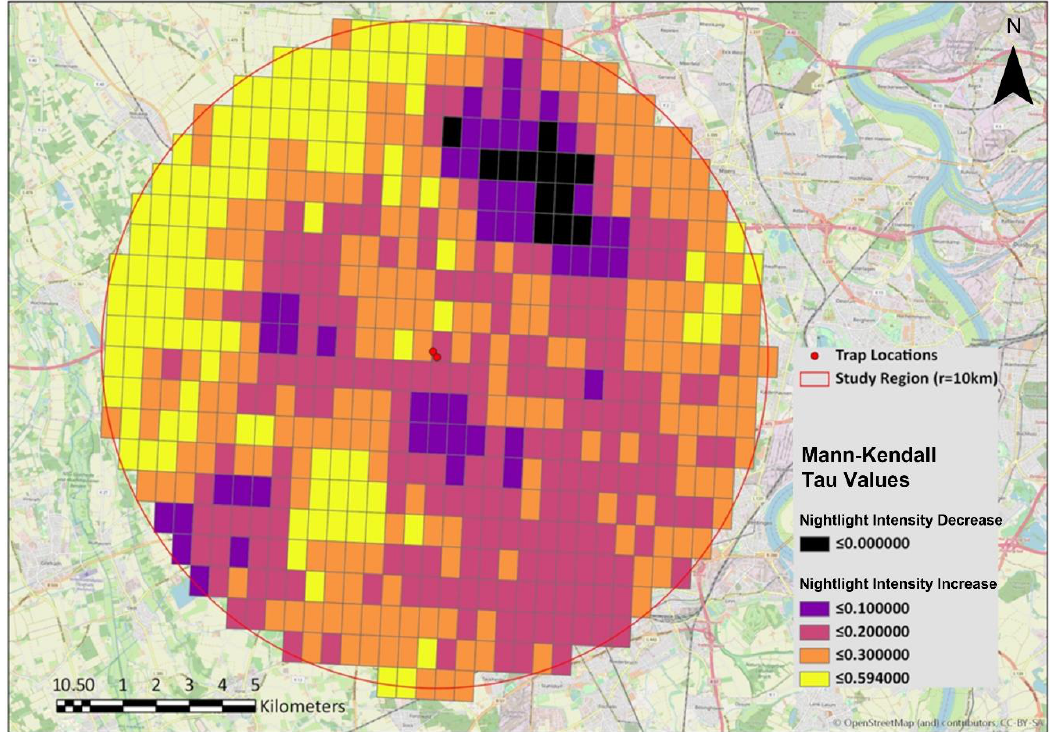
Figure 5. Mann – Kendall tau statistic across the region for the full time period; values closer to −1 and 1 represent more significant trends and values closer to 0 are less significant. Positive and negative values represent the directionality of monotonic trends.